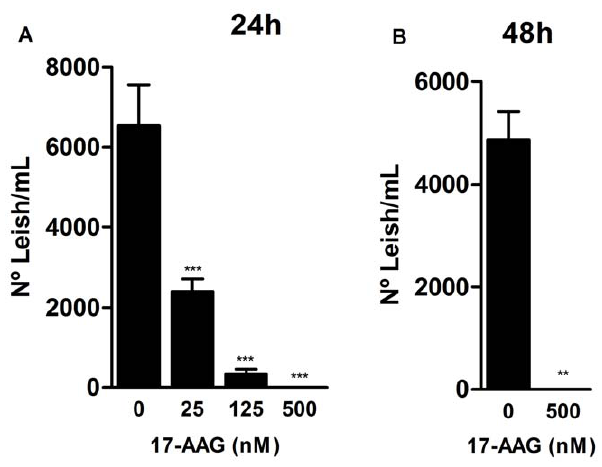
Figure 3. Reduction of parasite intracellular viability by 17- AAG. Treatment’s effect on parasite viability was assessed after 24 h ( A ) and 48 h ( B ) of infection, as described in Materials and Methods. Bars represent means 6 SD of one representative experiment out of two performed in sextuplicate (one-way ANOVA, *** p , 0.0001, Dun- nett’s Multiple Comparison Test, * p , 0.05, ** p , 0.001, *** p , 0.0001, post-test for linear trend, p , 0.0001; Mann Whitney test, ** p , 0.001).